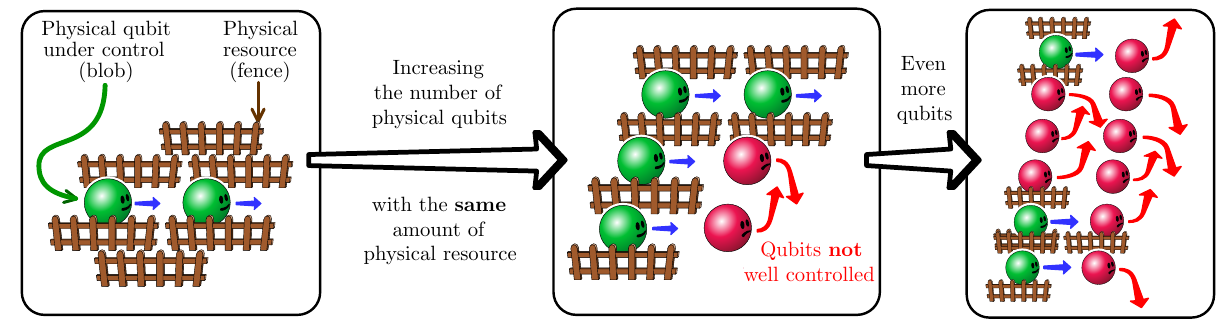
FIG. 1. How resource constraints can lead to increased computational errors. Each gate operation on a physical qubit (blob) requires a certain amount of physical resource (fence) for good control. If the number of physical qubits increases as the computer grows, without a proportionate increase in control resource, errors will